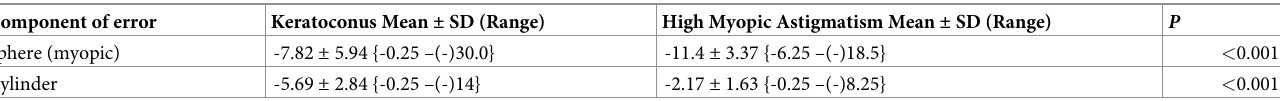
Table 3. Mean refractive errors of keratoconic and high myopic astigmatic eyes. Component of